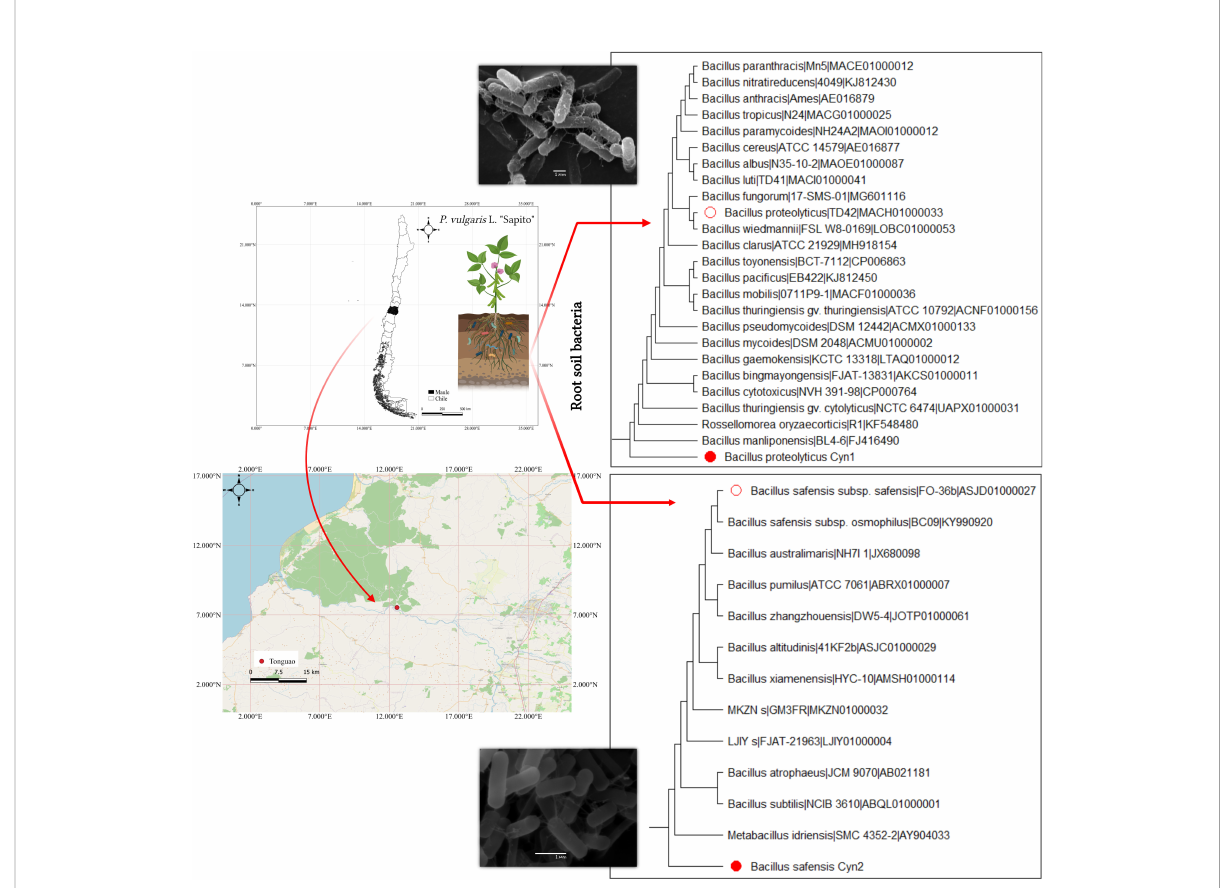
FIGURE 1 Study maps showing the location of the rhizosphere soil ( P . vulgaris L. “ Sapito ” ) collected from the Tonguao area of Maule region, Chile. On the right, the maximum likelihood phylogeny with 1,000 bootstrap value of the isolates Cyn1 and Cyn2 ( fi lled red circles) showing similarity with B. proteolyticus and B. safensis respectively, (outlined red circle) with scanning electron micrograph images of the bacterial isolates in respective